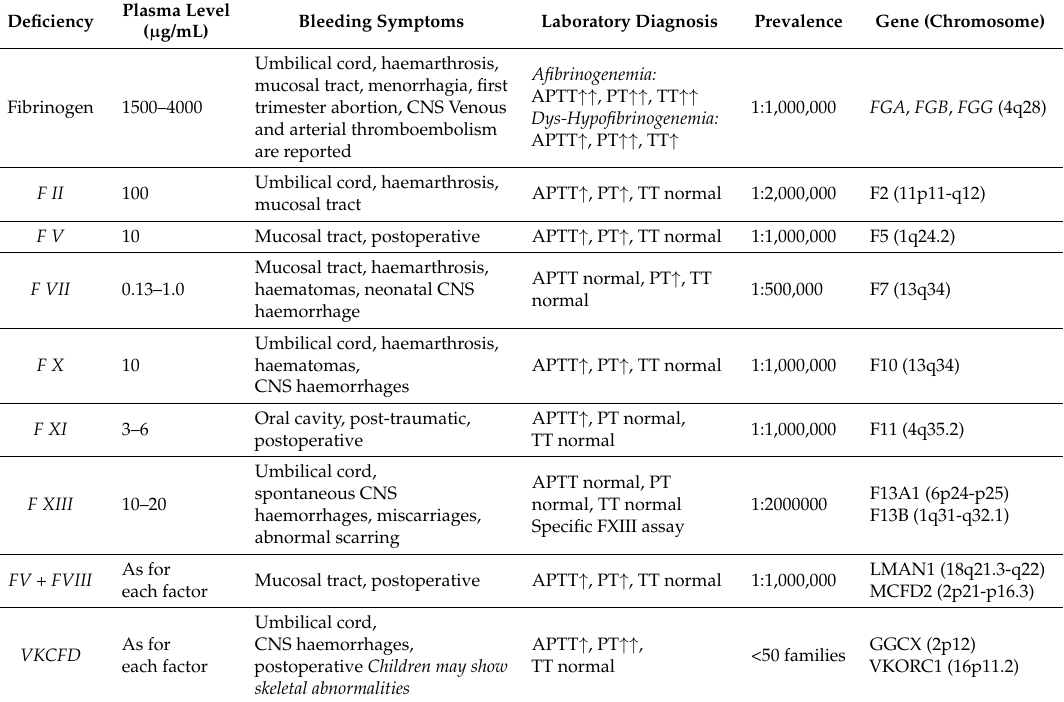
Table 5. Clinical symptoms, laboratory and molecular diagnosis in Rare Bleeding Disorders